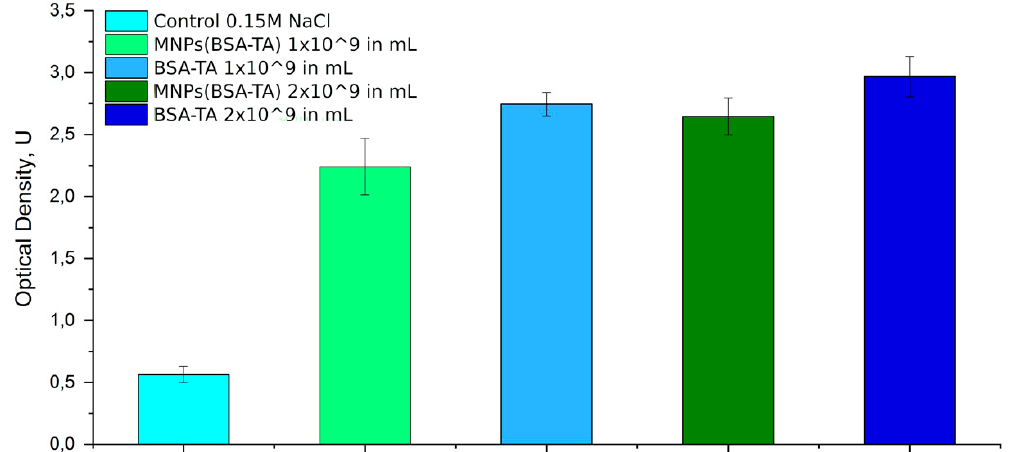
Figure 6. The e ff ect of BSA-TA and MNPs(BSA-TA) microcarriers on complement system. Determination of membrane attacking complex (MAC) concentration in human serum with ELISA assay. Dose-independent activation of complement system with both types of carriers. Levels of MAC in all experimental groups are significantly higher compared with the control group.